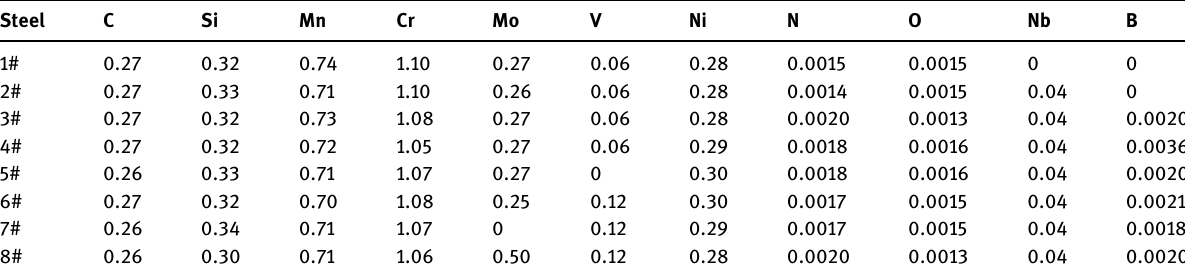
Table 1: The chemical compositions of the experimental steels ( wt% )